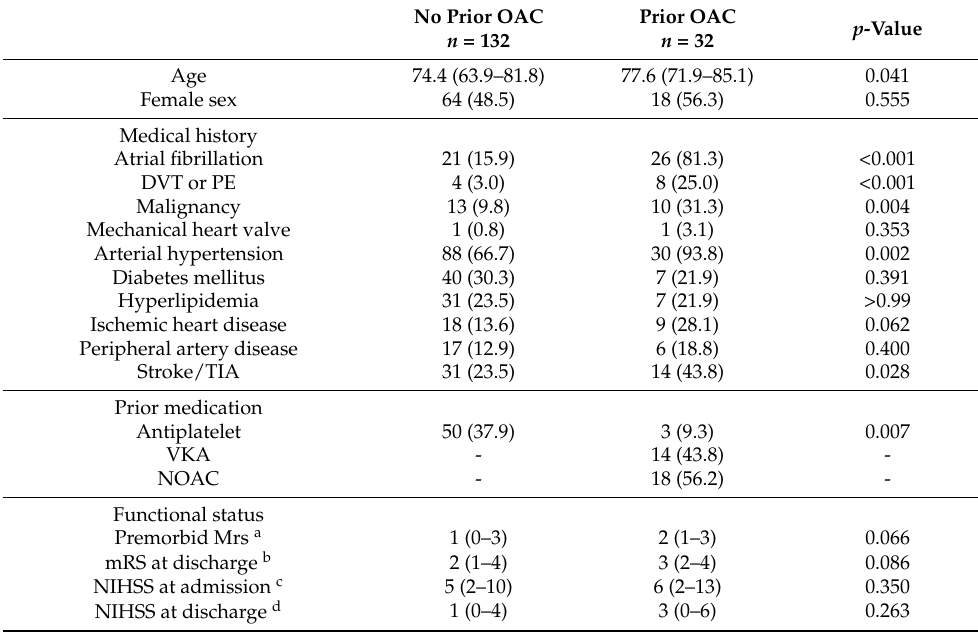
Table A1. Characteristics of patients with ischemic stroke presenting within 4.5 h after onset of symptoms categorized according to anticoagulation status at admission ( n = 164).